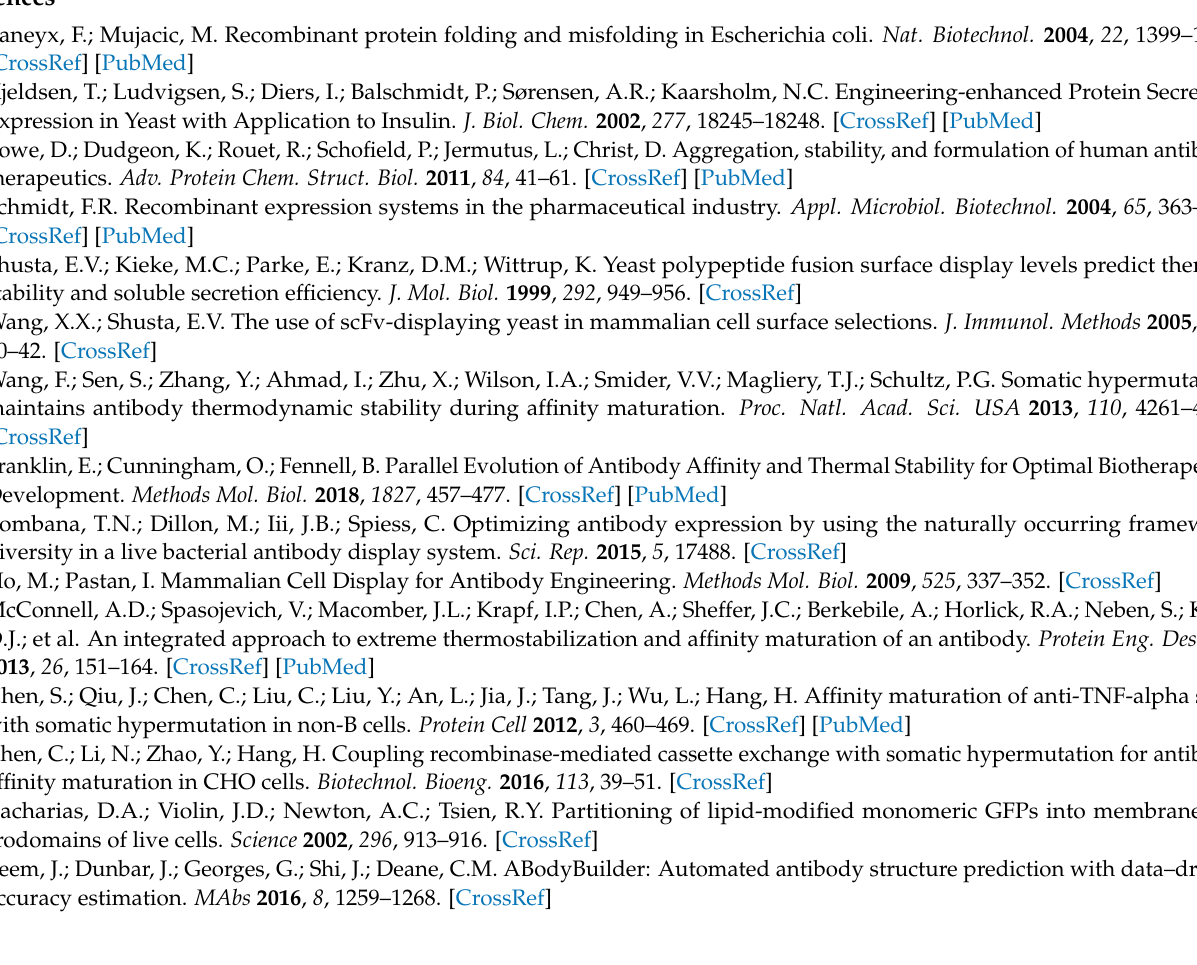
(SDS-PAGE); Table S1: Mutations observed during the affinity maturation procedure; Table S2: Amino acid sequence of anti-TNF α antibody variable region; Table S3: The molecular mass of different